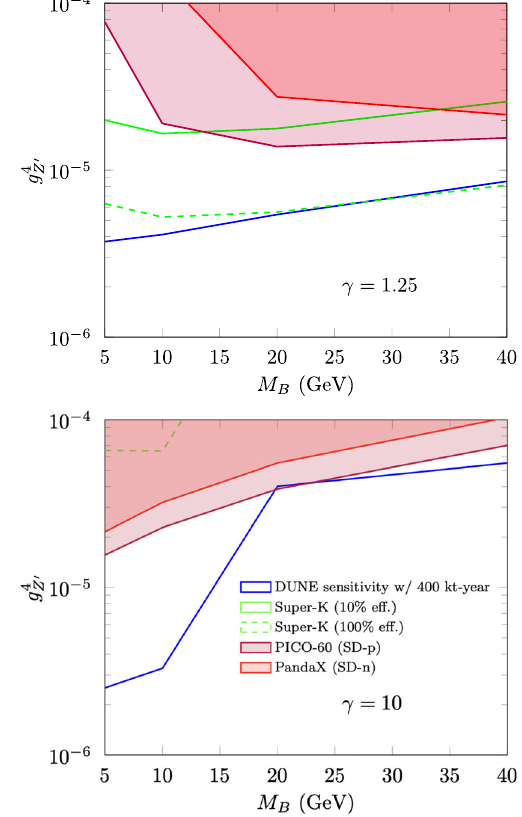
Fig. 27 Comparison of sensitivity of DUNE for 10 years of data col- lectionand40ktofdetectormasswithSuperKamiokande,assuming10 and 100% of the selection efficiency on the atmospheric neutrino anal- ysis in Ref. [222], and with the reinterpretations of the current results from PICO-60 [223] and PandaX [224]. The samples with two boosted factors, γ = 1 . 25 (top) and γ = 10 (bottom), are also